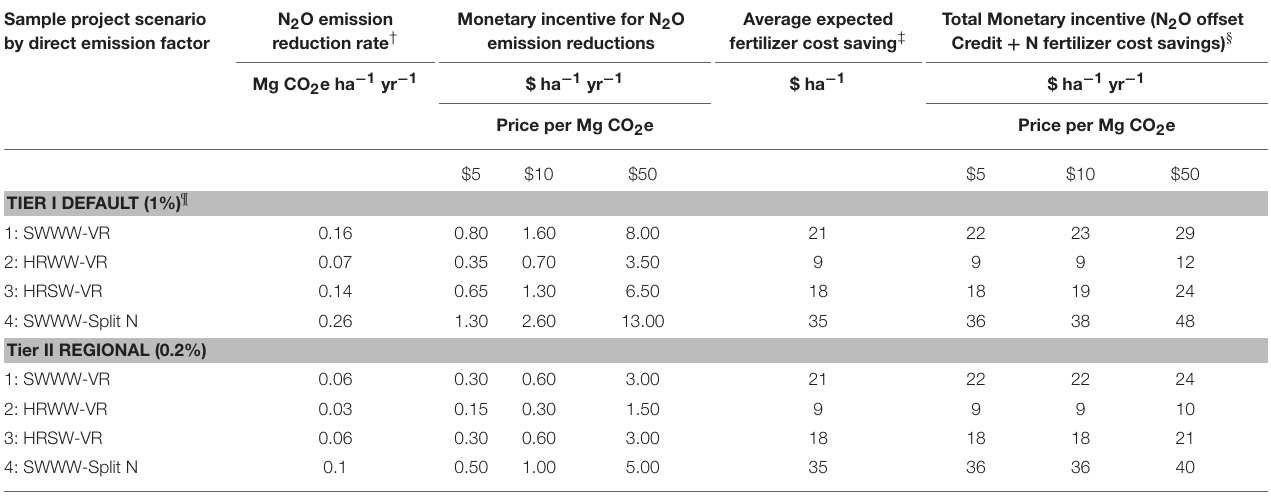
TABLE 8 | Including the fertilizer cost savings for calculating the offset credit incentive for the agricultural N management sample projects that reduce N 2 O emissions. Sample project scenario by direct emission factor